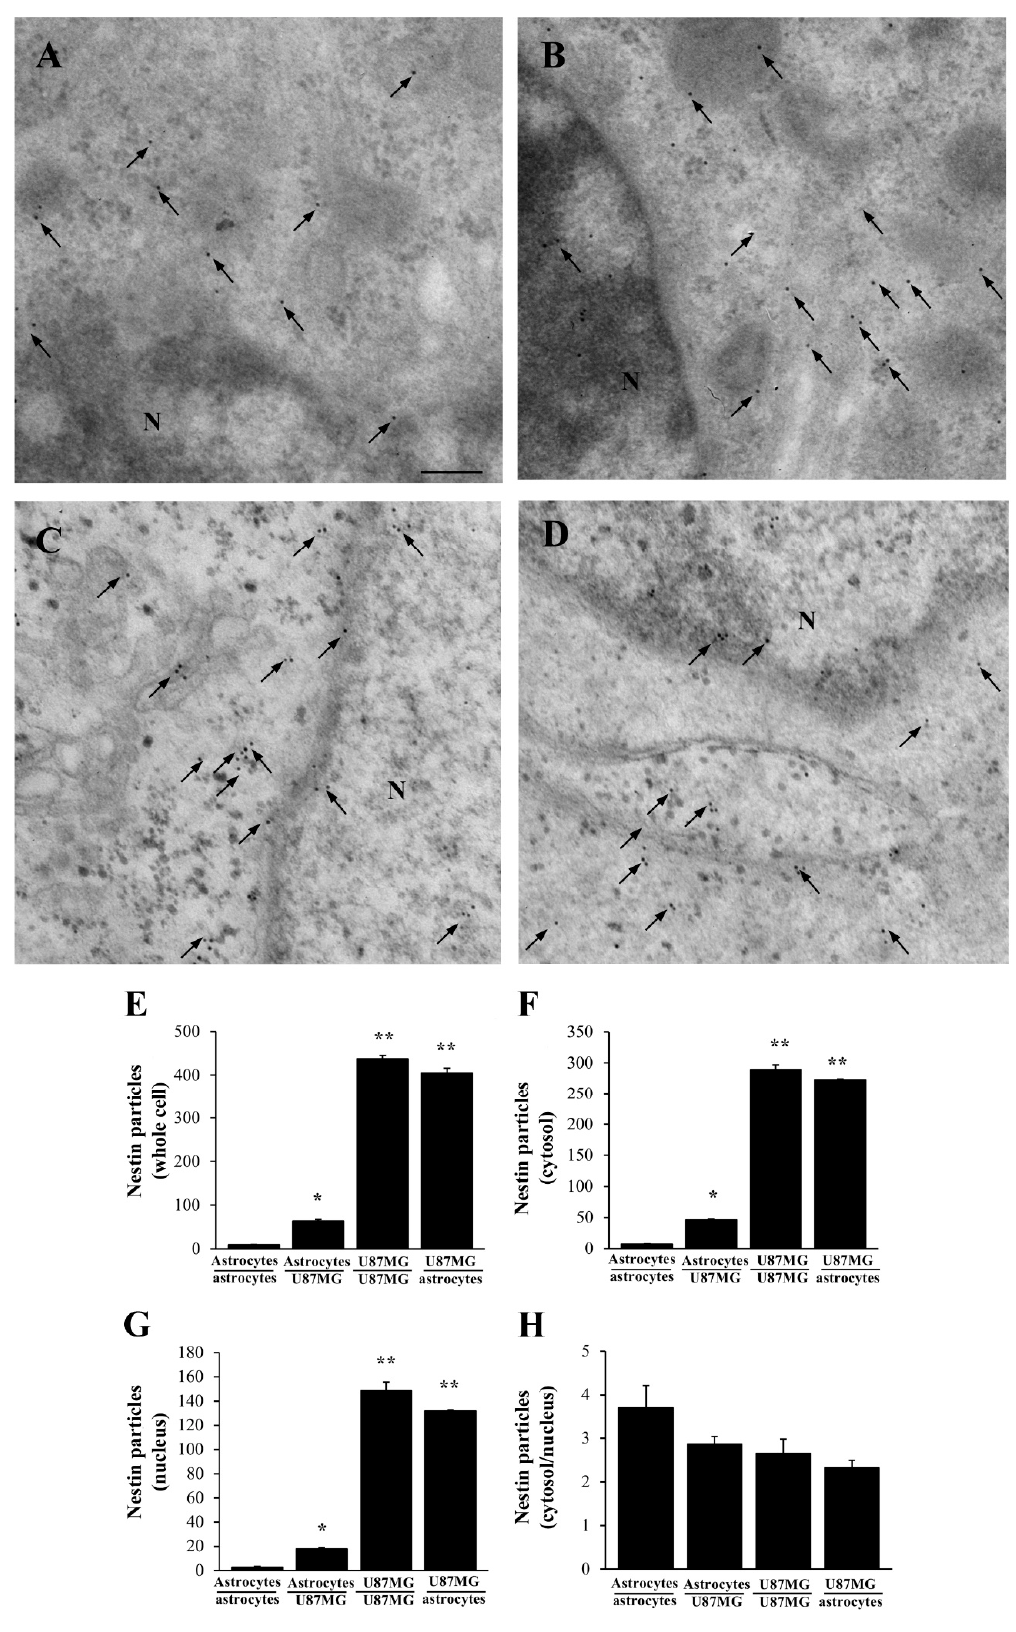
Figure 6. Nestin increases within astrocytes co-cultured with GBM cells. Representative